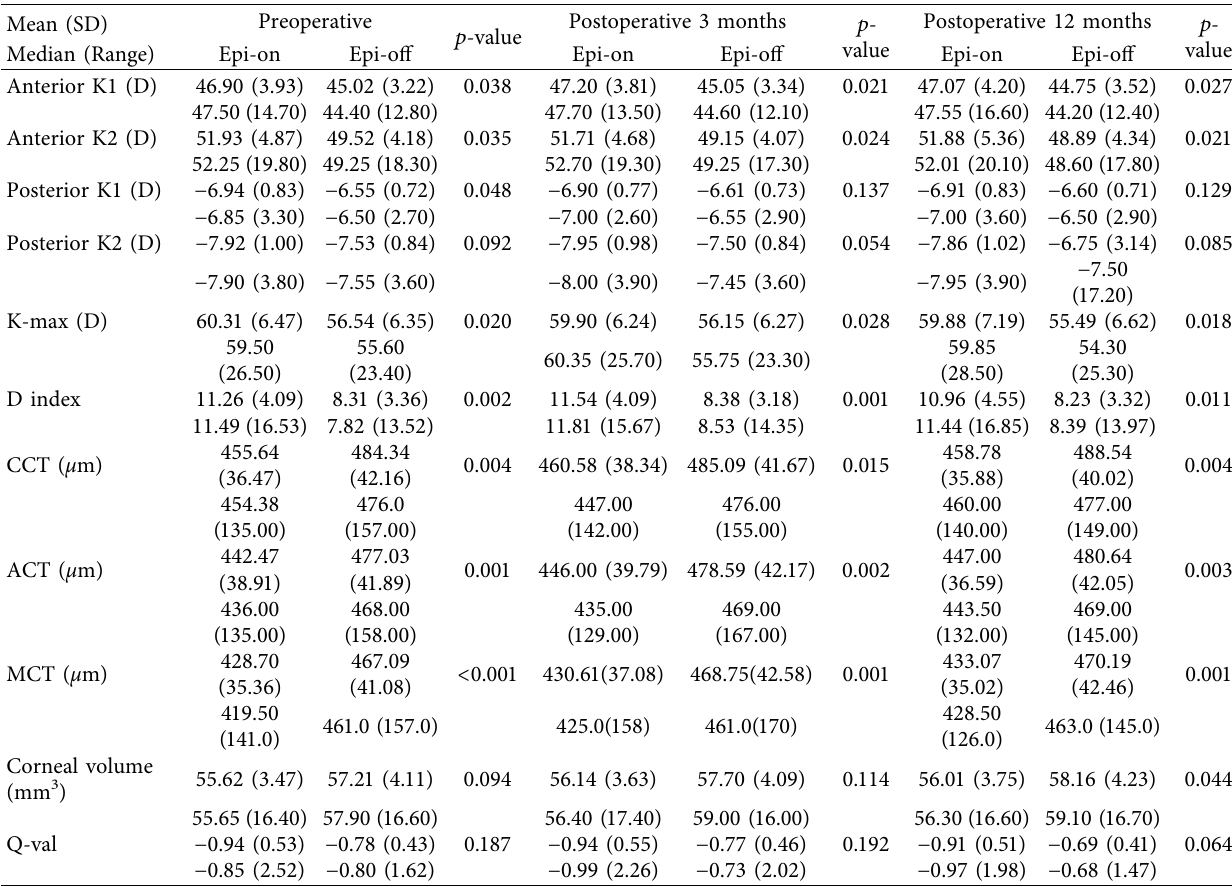
Table 3: Differences between the epi-on and epi-off groups in the corneal tomographic parameters in the different visits of the follow-up. Mean (SD)